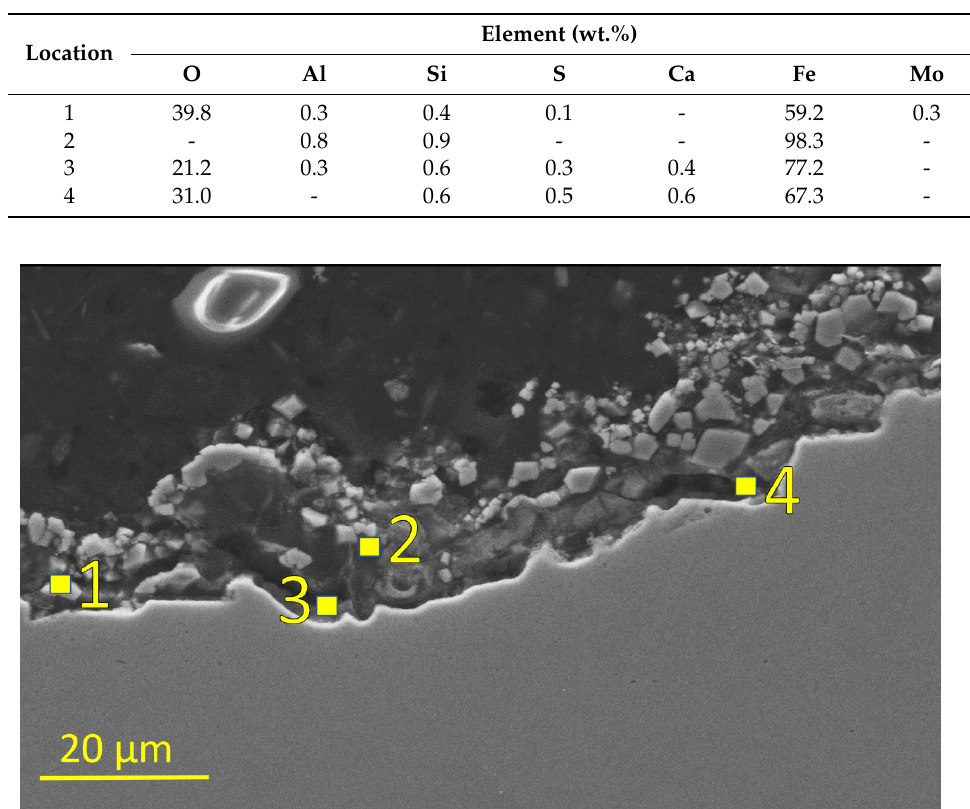
Figure 6. Cross-section of tested carbon-steel sample 1 one cm from the inlet of the first reactor. Table 7. Elemental analysis from locations in Figure 6.